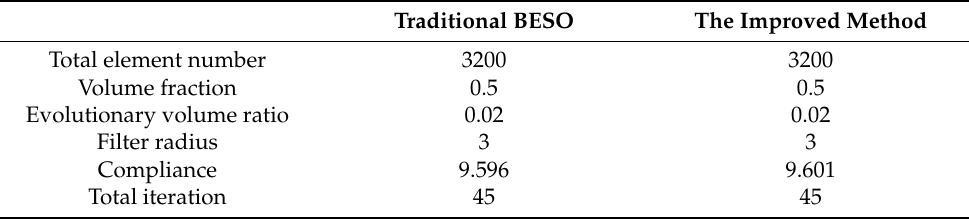
Table 1. Results for topology optimization of the simple bridge beam.